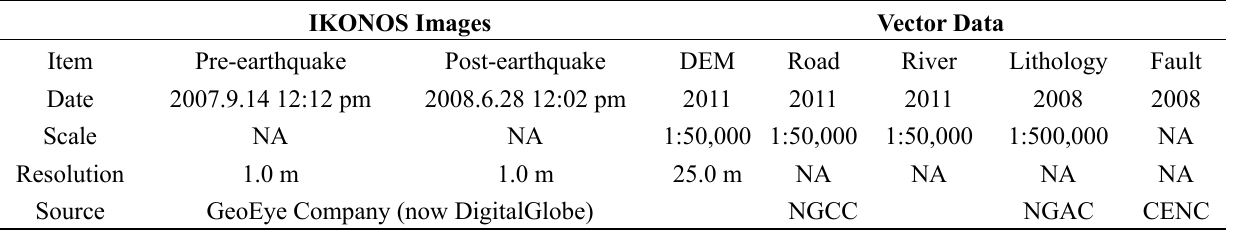
Table 1. Selected information on the IKONOS images and vector data used in the